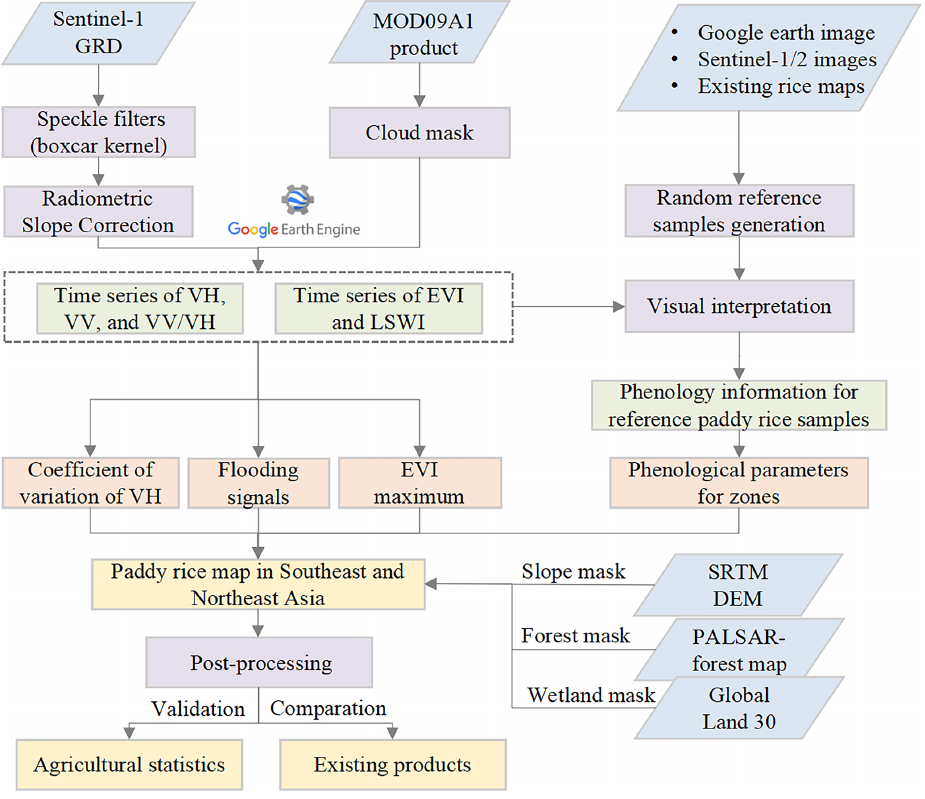
Figure 3. Flowchart for mapping paddy rice in SE and NE Asia using multiple